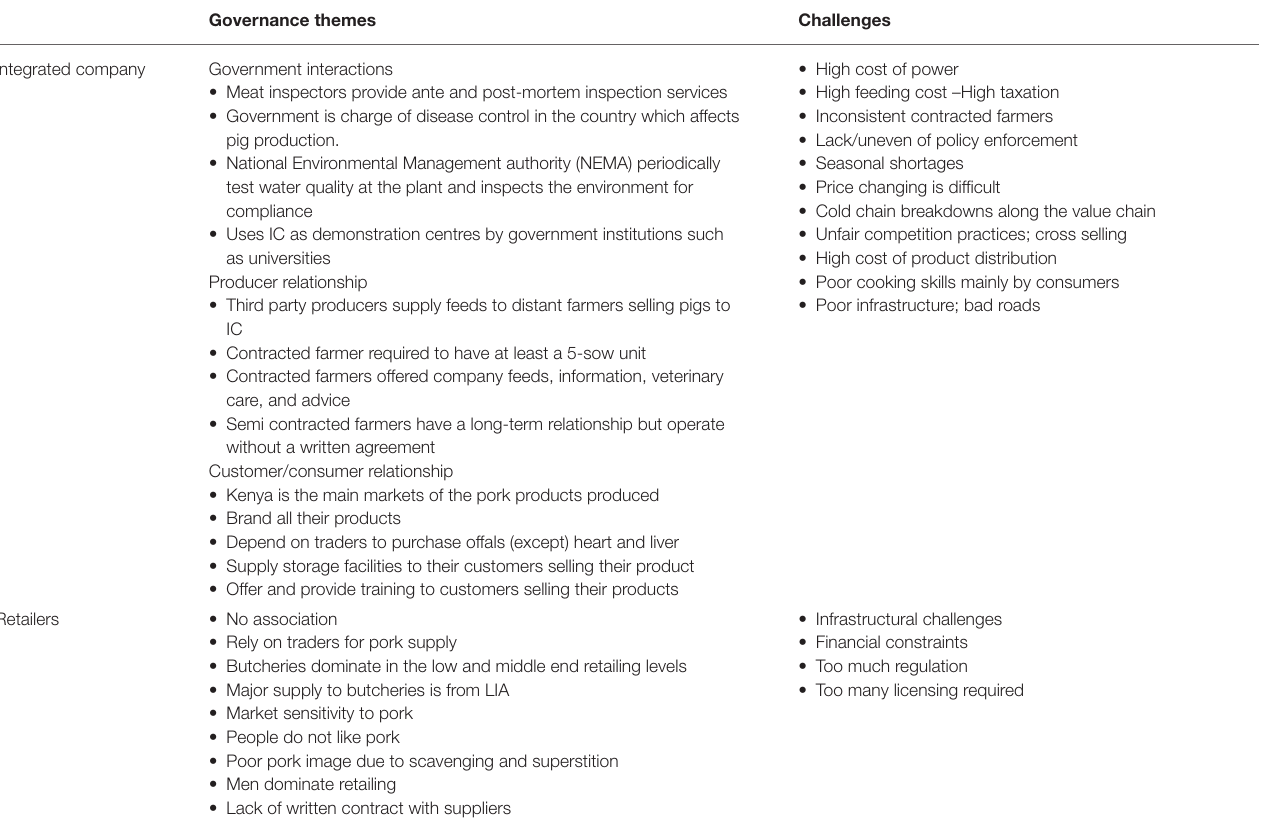
TABLE 4 | Governance themes and challenges reported by the Integrated company, and by public health officers in relation to Nairobi pork